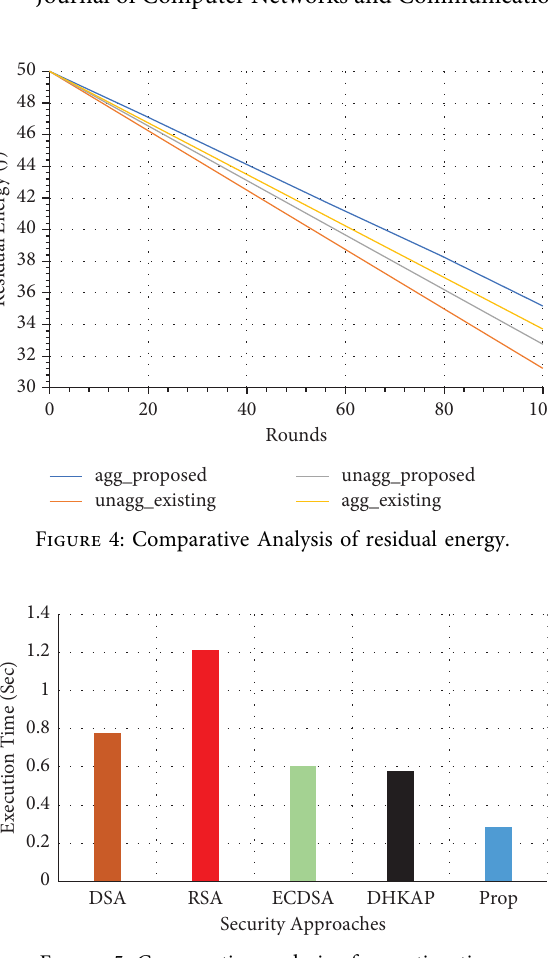
Figure 5: Comparative analysis of execution time.